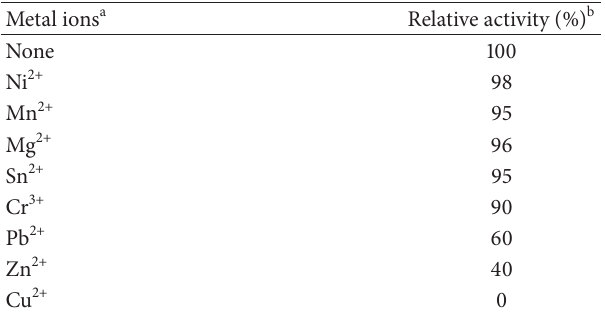
Table 2: Effect of metal ions on MDH activity of B. abortus